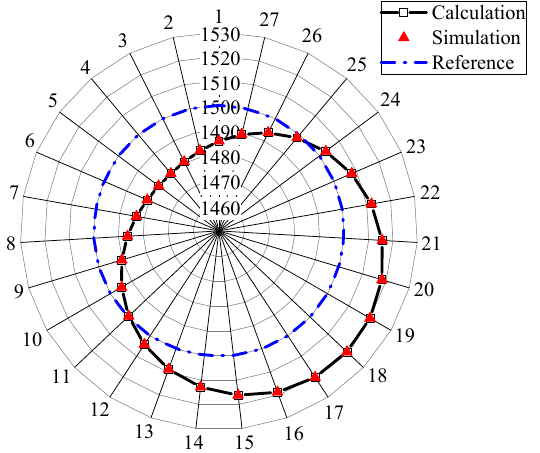
Figure 7. Mean Displacements of thrust cylinders in different groups.